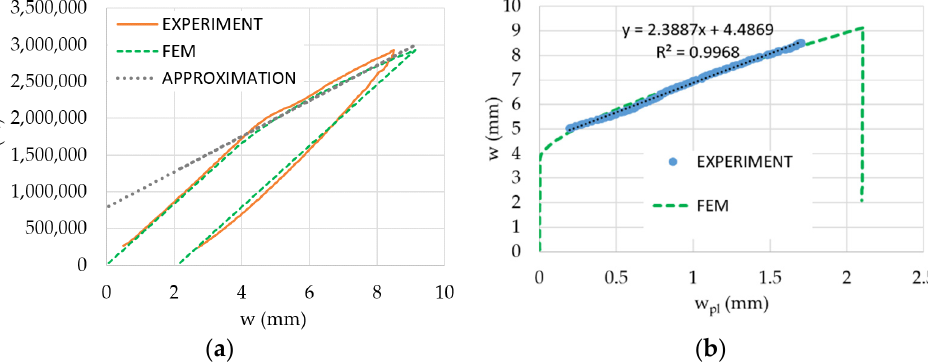
Figure 14. Boundary conditions for the first step of “S-shaped” billet simulation.